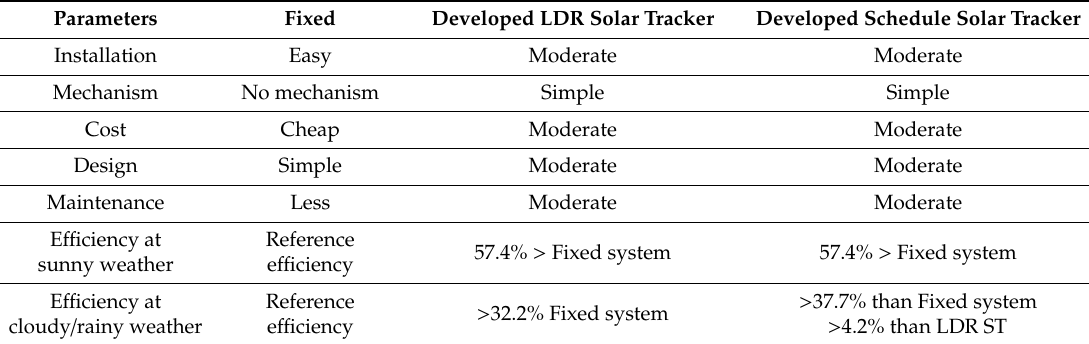
Table 1. The comparative results of experimental